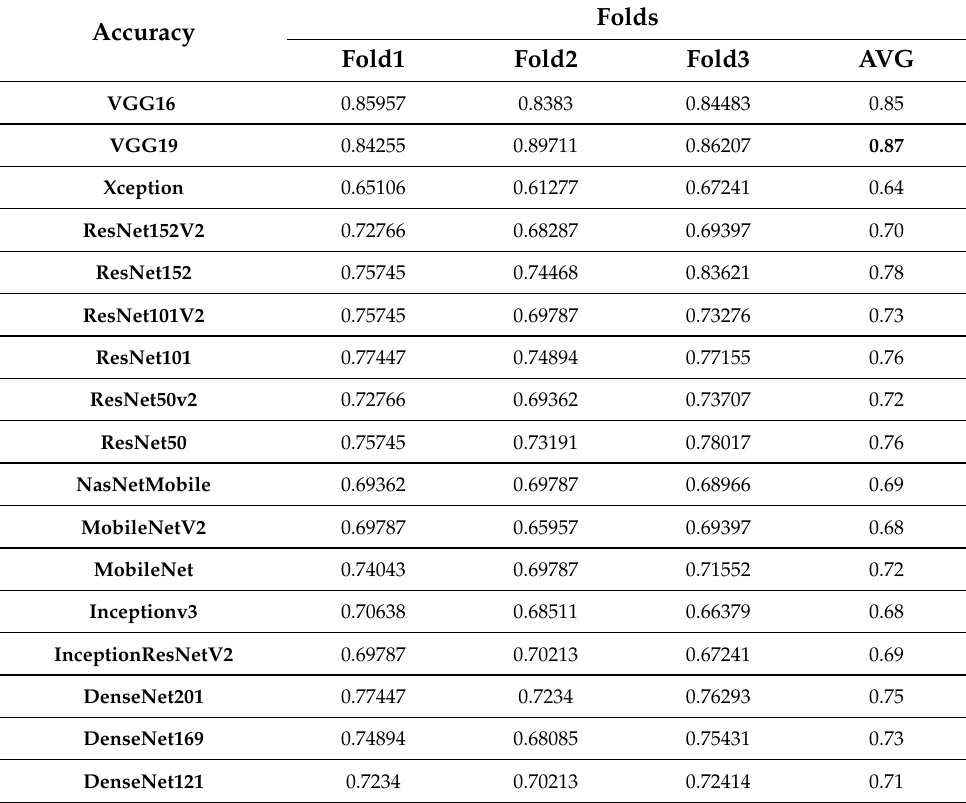
Table 6. Validation accuracy of CNN models using 3 class 3 folds after segment